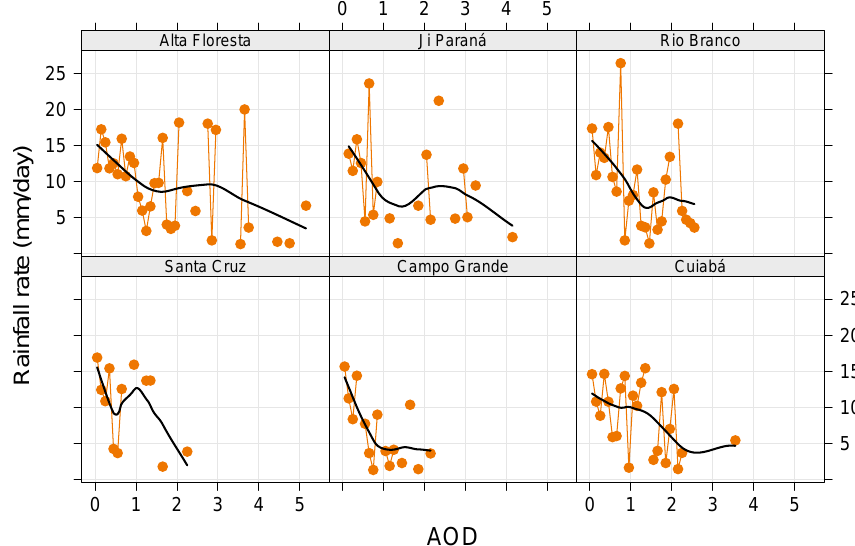
Fig. 7. Rainfall rate binned by the AOD range of 0.1 for each AERONET station for all selected cases (see Sect. 2.4) during the months